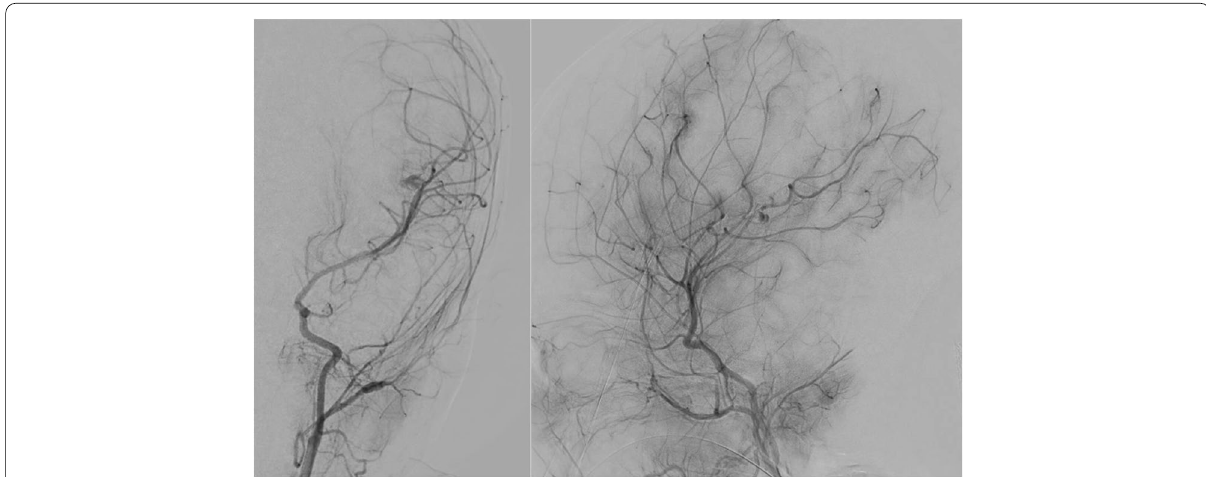
Fig. 4 Cerebral arteriography of case 2, showing partially thrombosed distal MCA aneurysm. No contrast